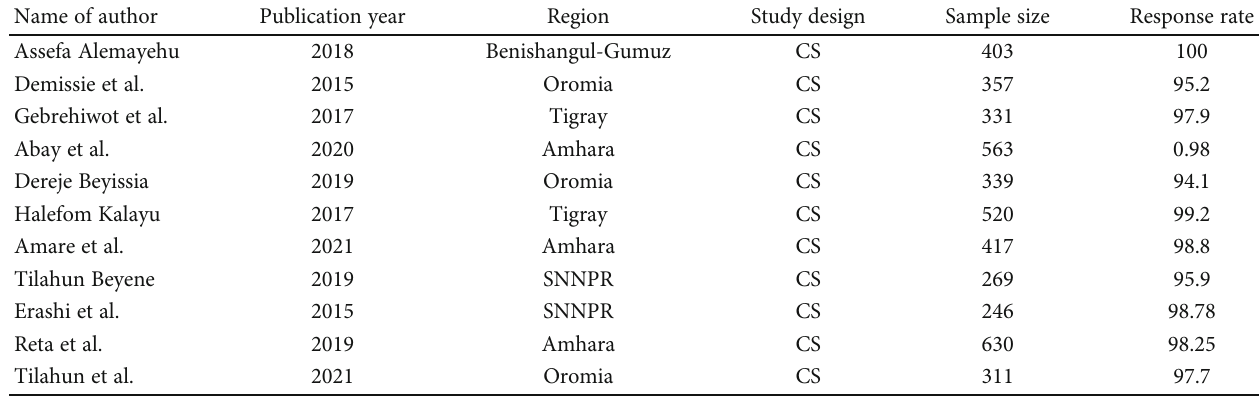
Table 1: Descriptive summary of 11 studies included in the meta-analysis of dual contraceptive use in Ethiopia. Name of